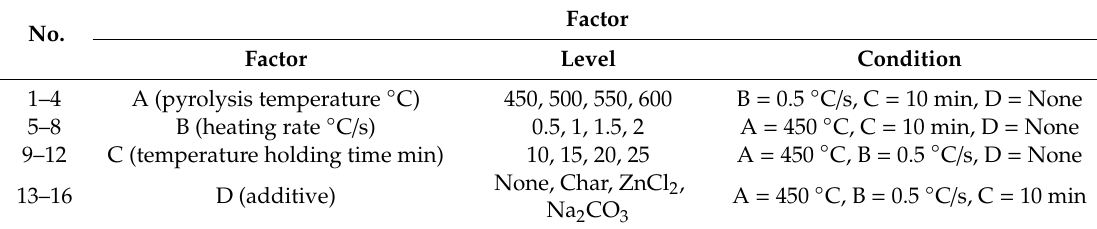
Table 2. The single factor experiment conditions.